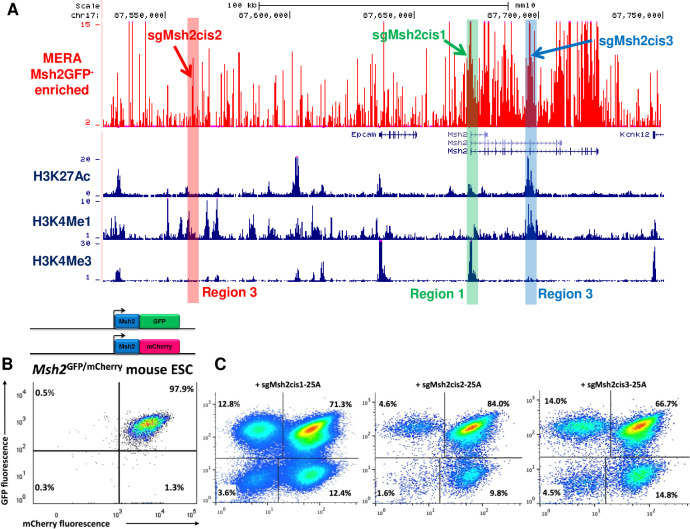
Mutations at Msh2 regulatory regions infrequently induce biallelic loss of expression.(A) UCSC browser track showing MERA screen ratio of gRNA abundance in Msh2GFP- vs bulk pools for ~12,000 gRNAs tiled across the Msh2 cis-regulatory region in mESCs. ENCODE histone modification tracks are shown underneath plot, and gRNAs chosen for follow-up are highlighted. (B) Flow cytometry plot showing Msh2GFP/mCherry mESC line before CRISPR/Cas9 targeting. (C) Flow cytometry plots of Msh2GFP/mCherry mESCs after targeting with three cis-gRNAs, showing infrequent biallelic loss of expression.